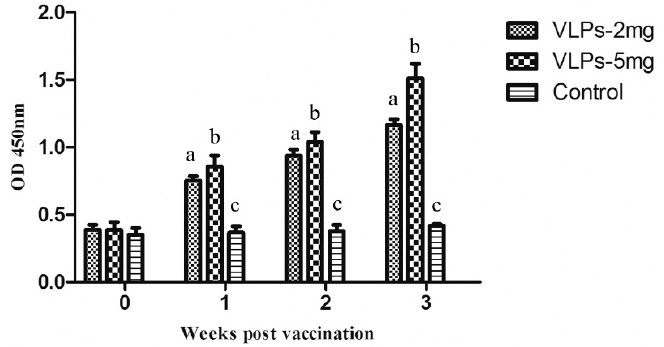
Figure 4. Serum antibody responses in rabbits after immunization with RHDV2 VLPs. Rabbit sera from di ff erent groups of immunized animals were collected at 0, 1, 2 and 3 weeks post immunization and then analysed by indirect ELISA. All rabbit sera were diluted to 1:500 before testing.